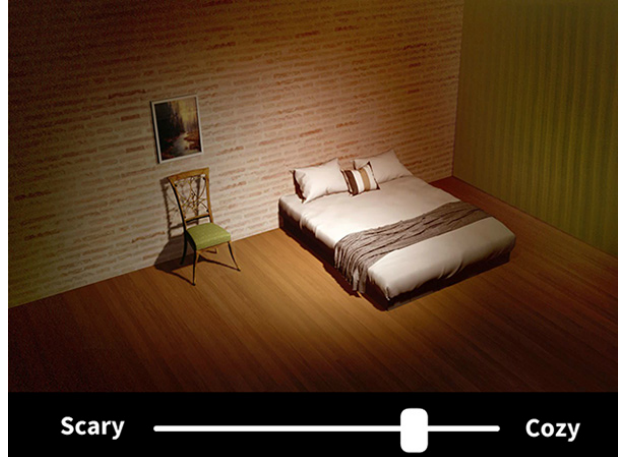
Figure 13. Example of a CUI capable of switching the scene between the states “cozy” and